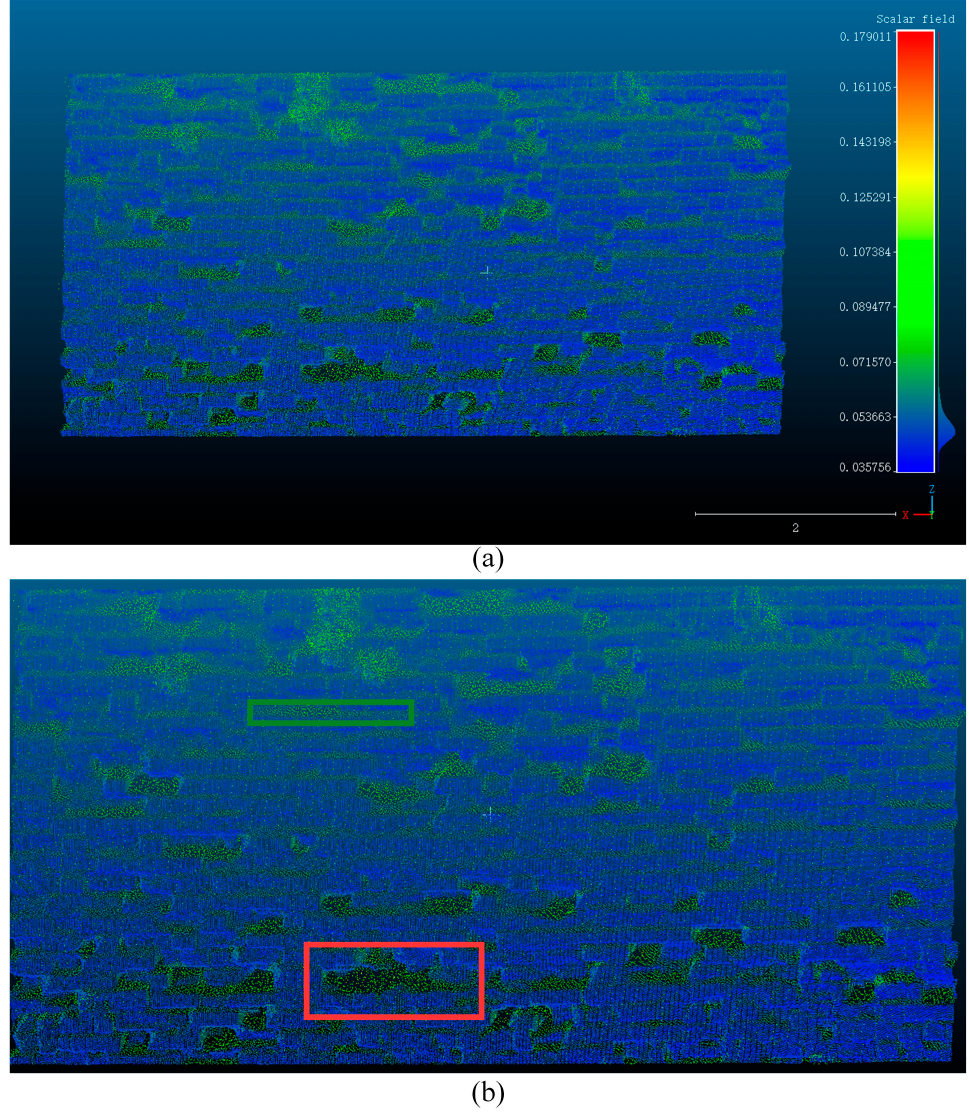
Figure 27. ( a ) Visualization of Structural Tensor Omnivariance. ( b ) Defect analysis diagram. (The red box indicates the detachment of bricks; the green box indicates cracks in the wall).